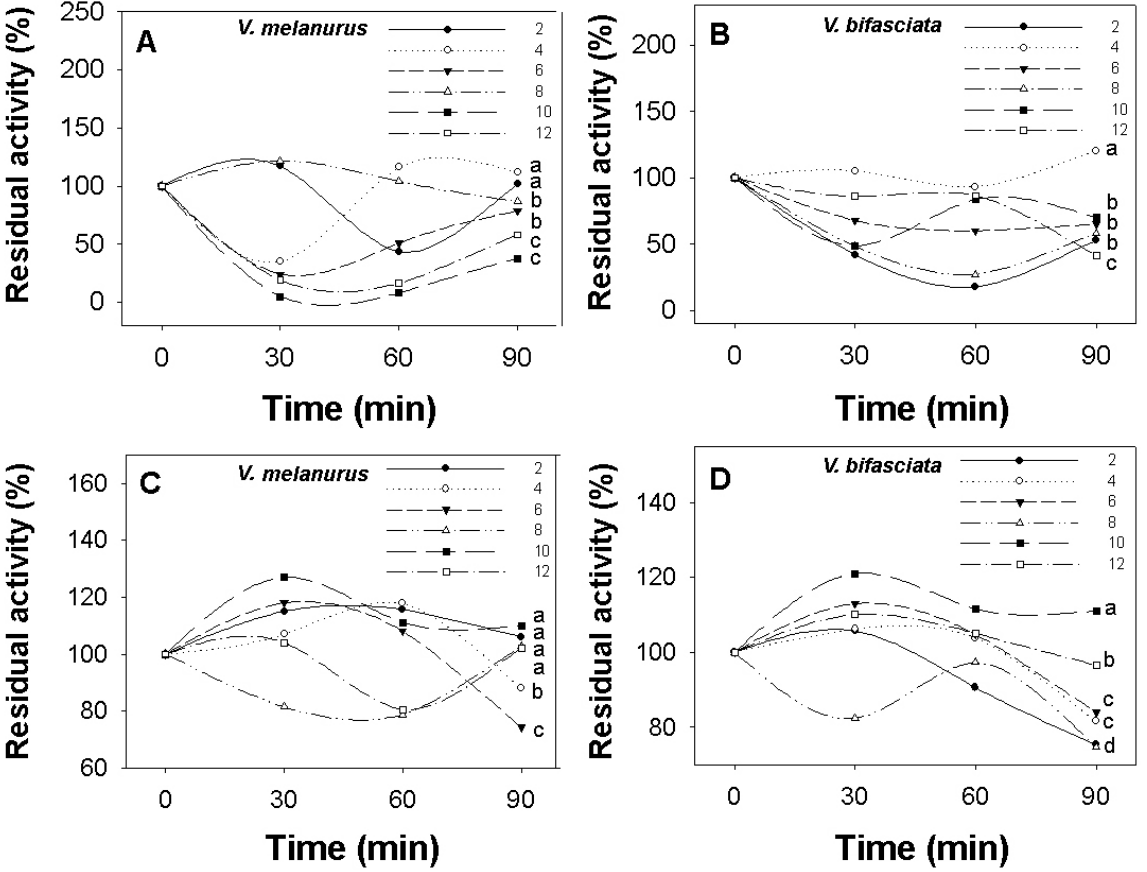
FIGURE 2 | pH stability of acid digestive protease for A . Vieja melanurus and B . V. bifasciata ; and alkaline digestive protease for C . V. melanurus and D . V. bifasciata (mean ± SD, n = 3). Significant differences (P< 0.05) between pH values residual activity are shown by letters.